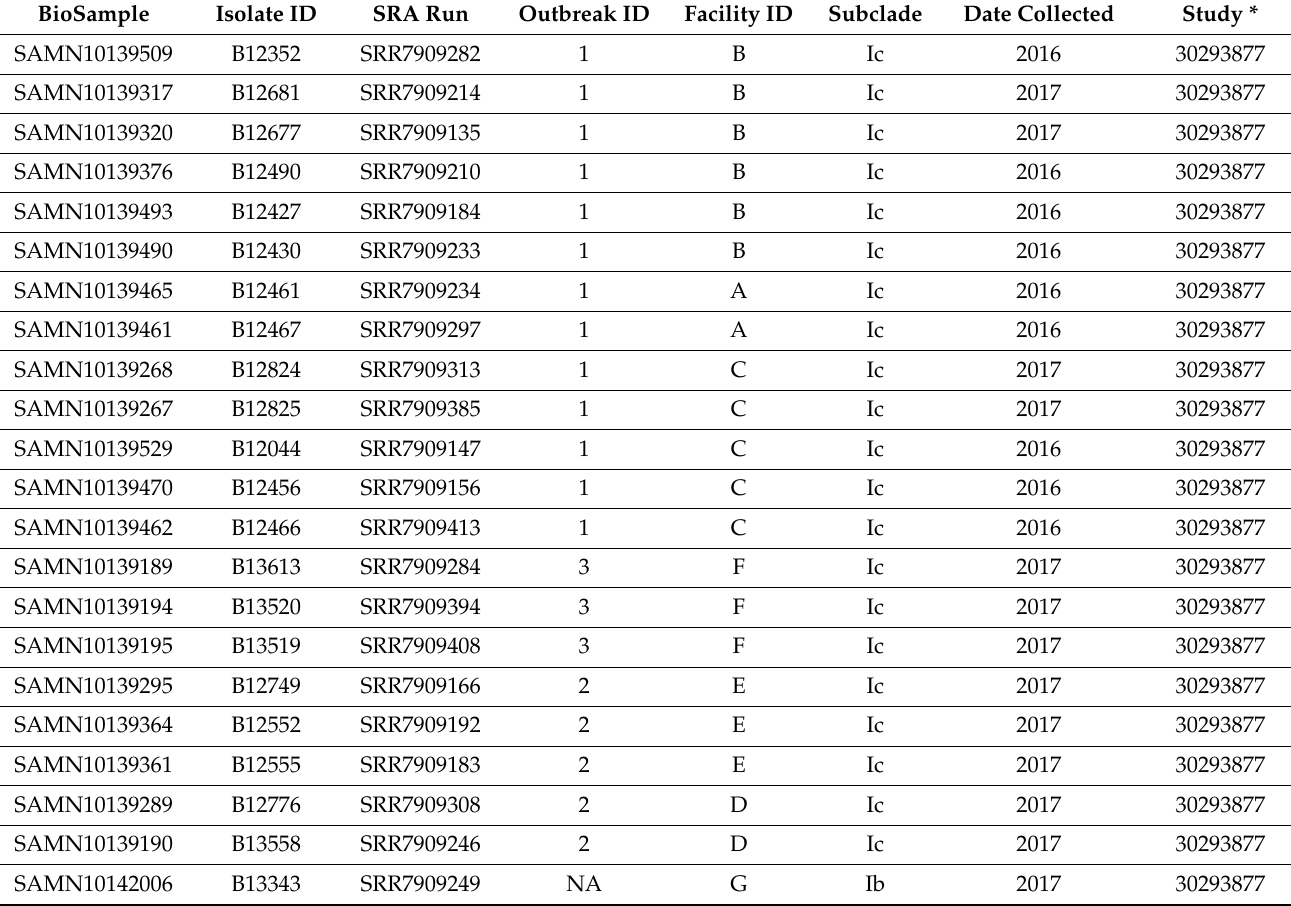
Table 1. List of sequences included in the Candida auris whole-genome sequence benchmark